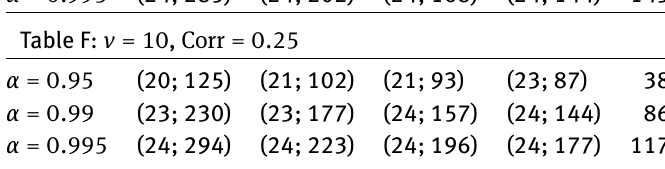
Table F: ν = 10 , Corr =